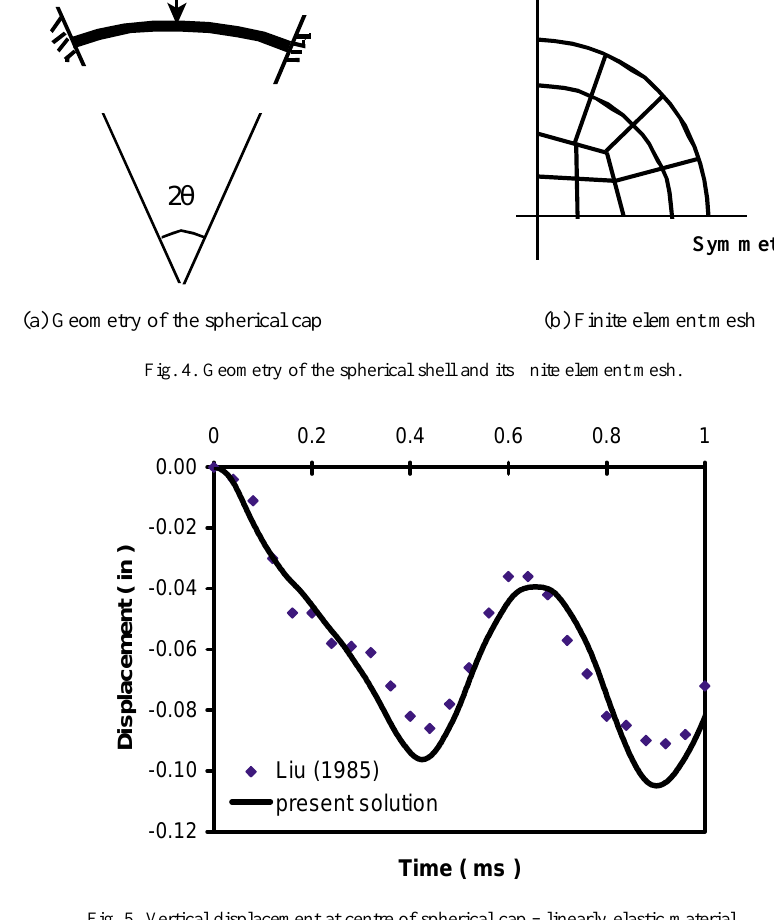
Fig. 5. Vertical displacement at centre of spherical cap – linearly elastic